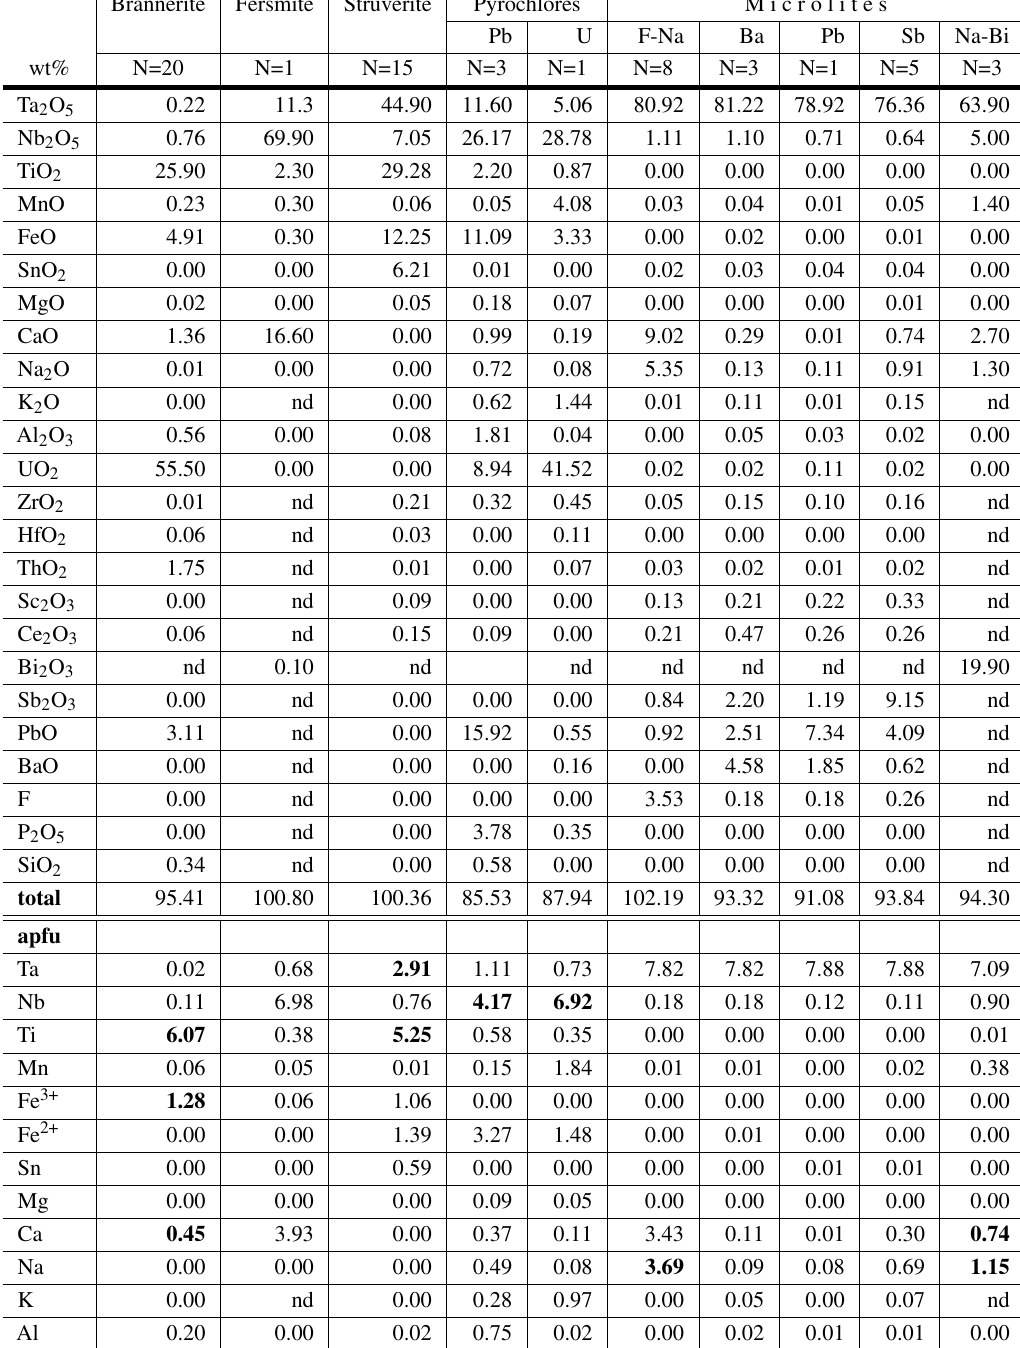
Representative microprobe analyses of tantalate mineral species new in the BPP. Na-Bi-microlite and fersmite data obtained at USP, strüverite at GFZP, brannerite, microlites and pyrochlores data obtained at both, USP and